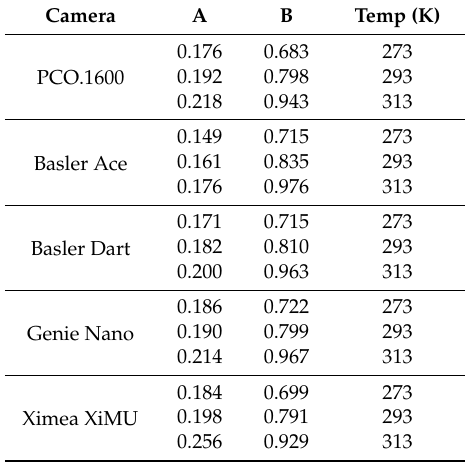
Table 4. Comparison of PSP Calibration Parameters.